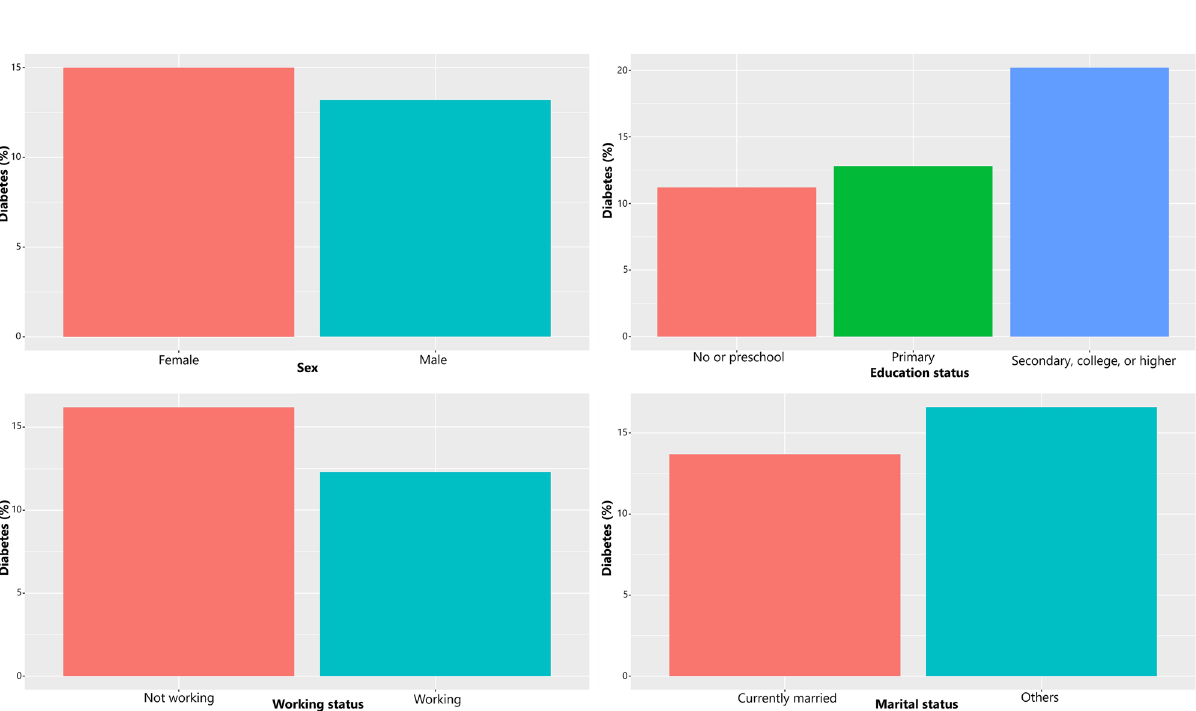
Figure 1. Distribution of diabetes by selected sociodemographic